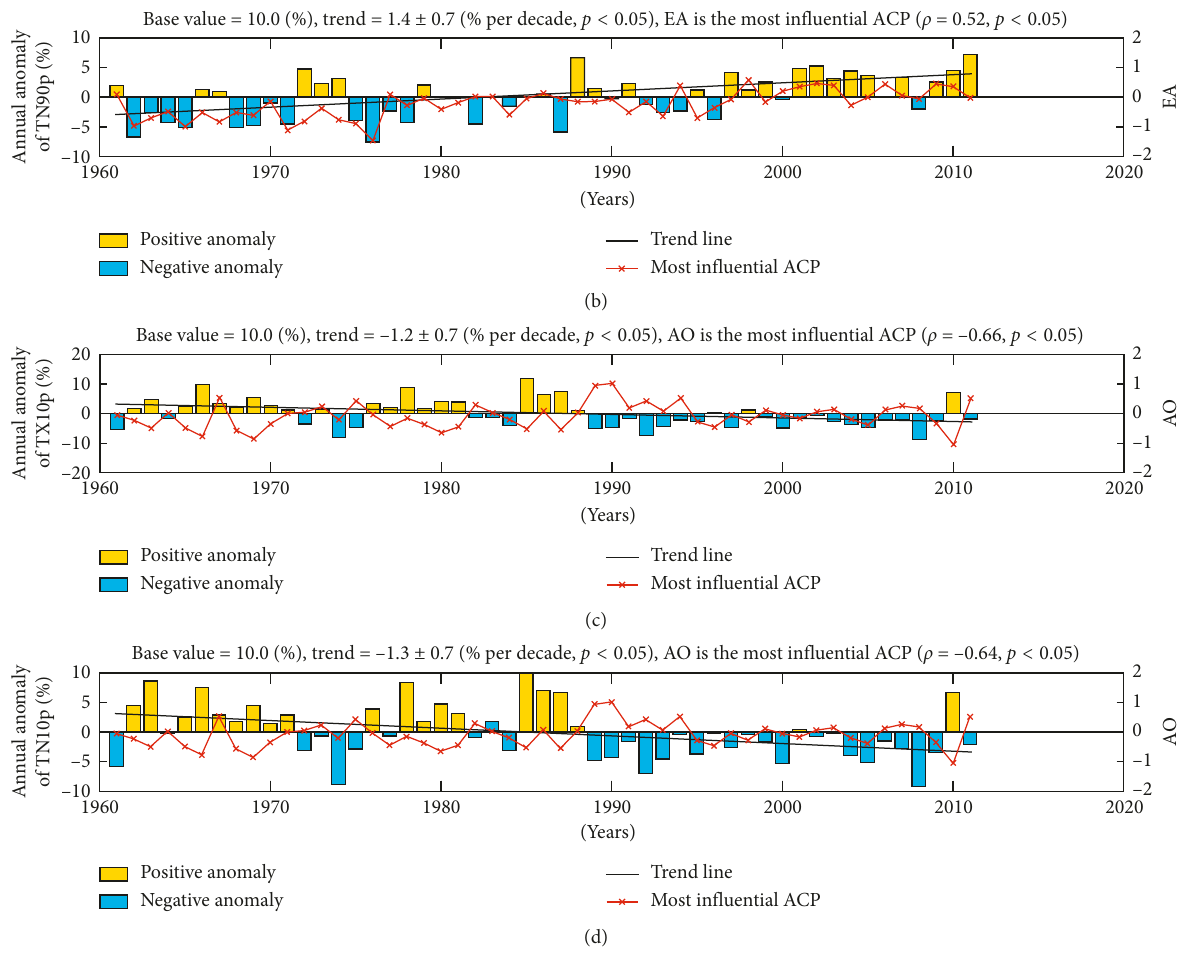
Figure 2: Time series with trend line and most influential NHTP for (a) TX90p, (b) TN90p, (c) TX10p, and (d) TN10p, on the country scale in Finland during Table 3: Base value (average during 1961–2011), statistically significant ( p for daily extreme temperature indices given in Table 1.